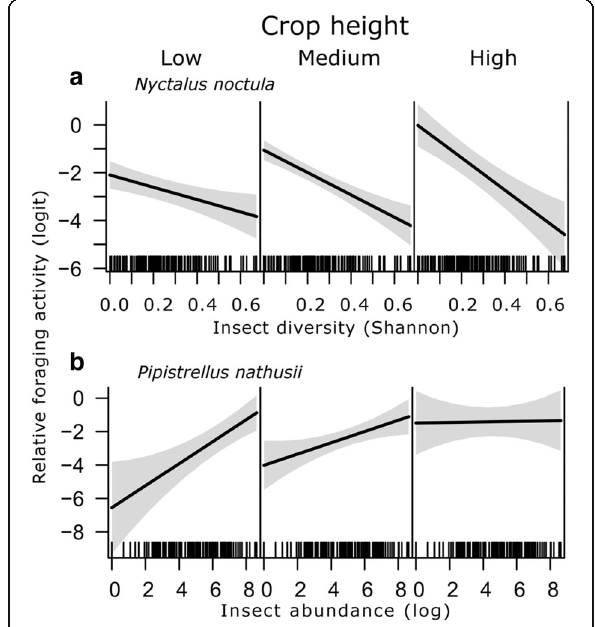
Fig. 7 Effect plots for interaction effects show how low, medium, and high values of crop height influence the relationship between relative foraging activity and the proxies for prey